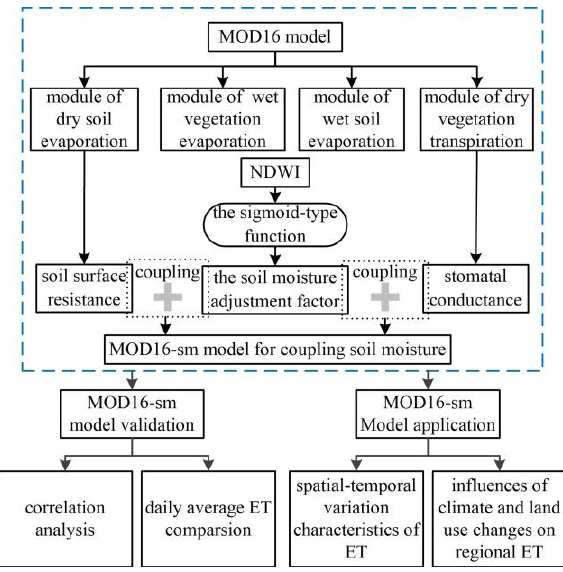
Figure 2. The flow chart of the study (blue dashed frame: improvements of the MOD16 model).